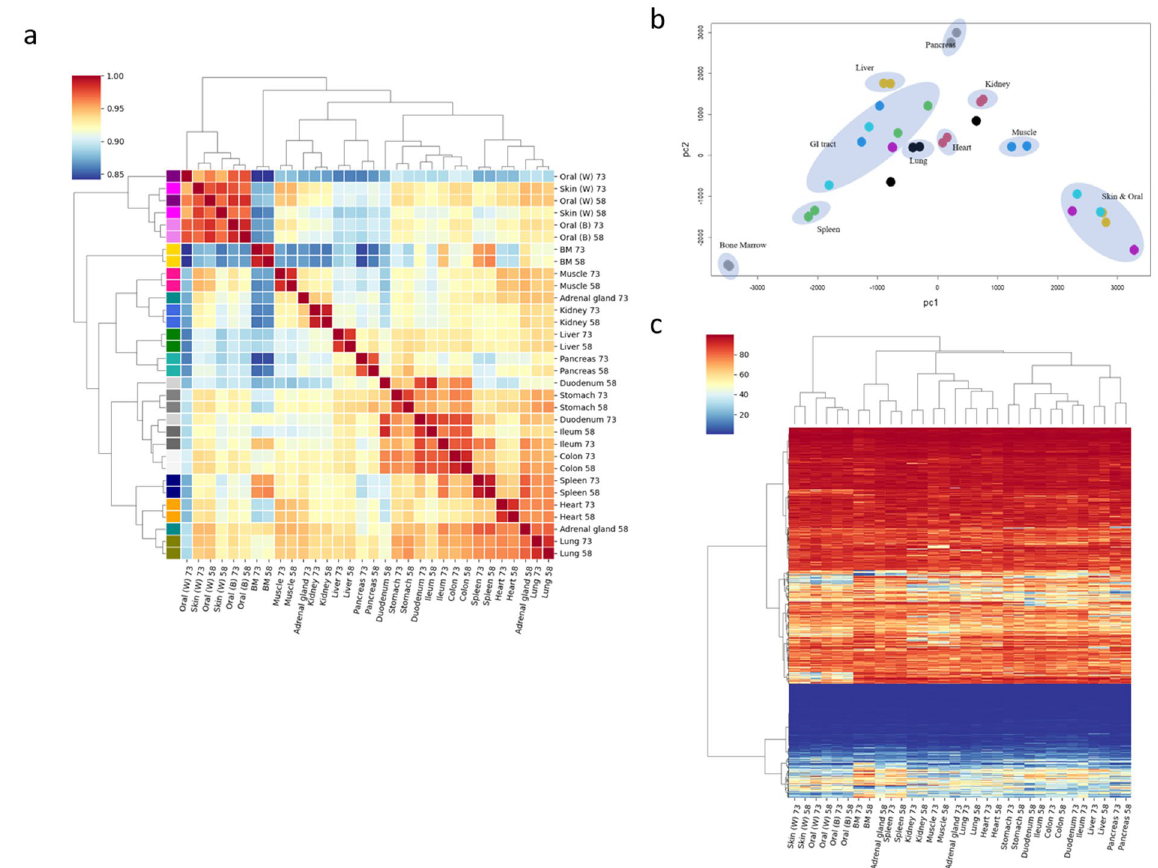
Figure 3. ( a ) Pairplot for correlation scores of DNA methylation levels with all CpG sites analyzed by Canine DREAM. Samples include lung, heart, stomach, duodenum, ileum, colon, liver, pancreas, adrenal gland, kidney, spleen, muscle, skin (white-colored), oral mucosa (white-colored and black-colored), and bone marrow. Also shown is ( b ) Principal Component Analysis (depicted by R, https:// www.R- proje ct. org/.) and ( c ) Unsupervised hierarchical analyses of DNA methylation levels with all CpG sites analyzed by Canine DREAM. All figures are depicted by seaborn (https:// doi. org/ 10. 5281/ zenodo. 592845) except for ( b